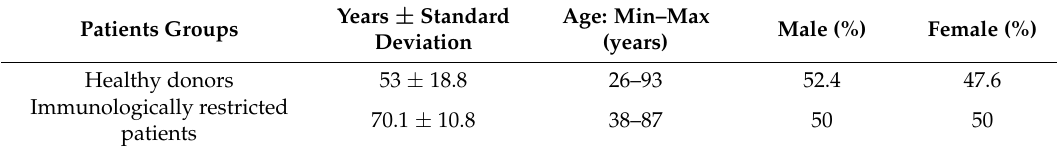
Table 3. Patient